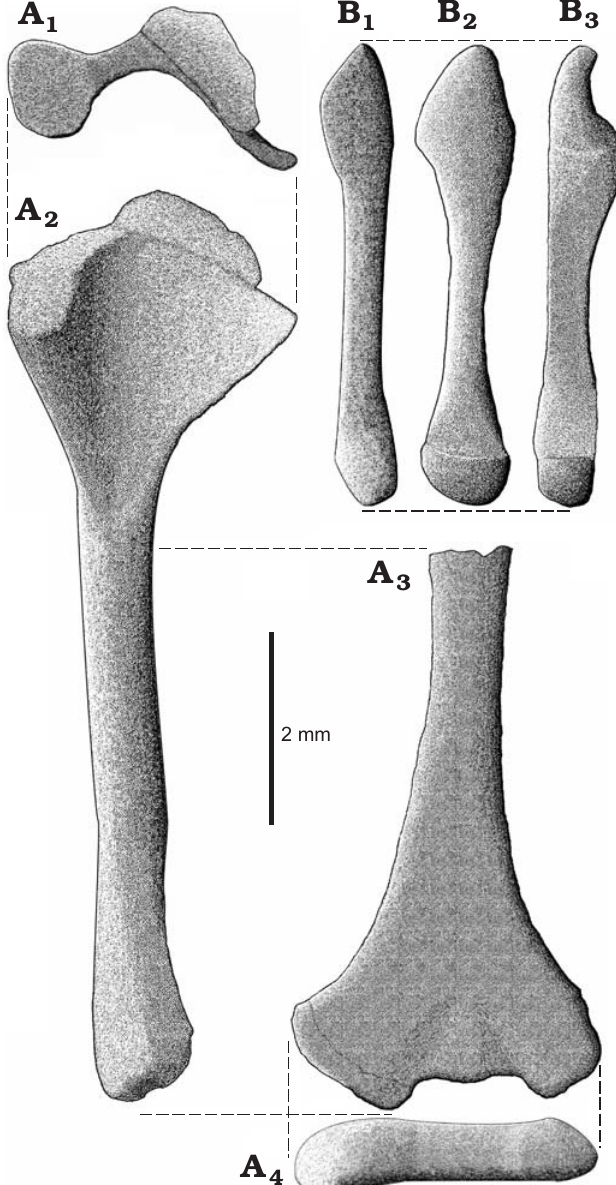
Fig. 6. Reconstruction of right humerus ( A ) and ulna ( B ) of Slavoia darevskii . A . ZPAL MgR-I/8, holotype. Proximal head with partially pre- served epiphysis in proximal (A 1 ) and ventral (A 2 ) views, the shaft and dis- tal head in medial view (A 3 ), and distal head in distal view (A 4 ). B . ZPAL MgR-I/9, subadult, in lateral (B 1 ), posterior (B 2 ), and medial (B 3 )